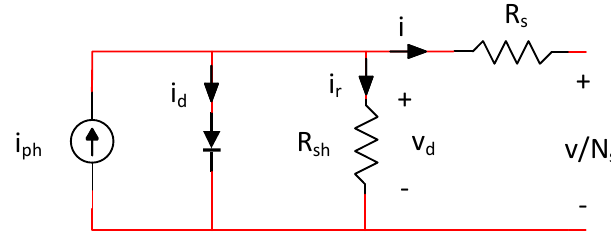
Figure 3. PV cell equivalent circuit.